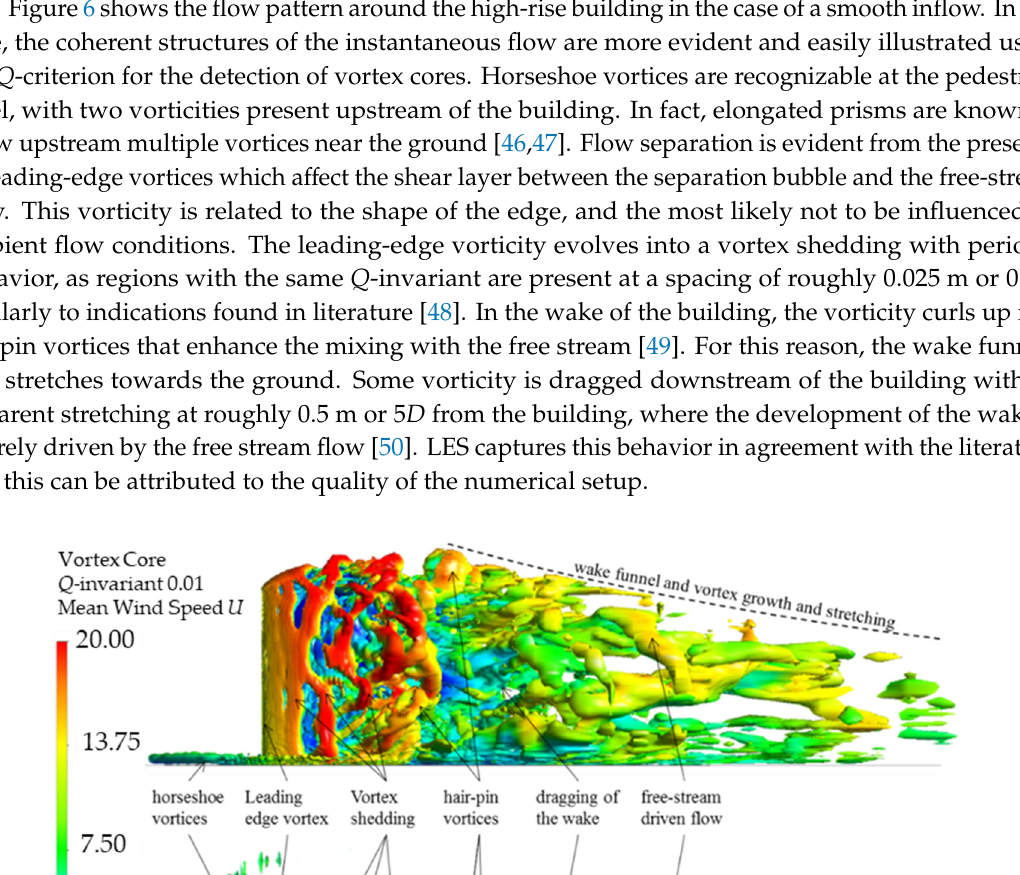
Figure 7. Flow pattern in terms of velocity-invariant Q = 0.1 around the high-rise buildingin case of ( a ) RANS smooth ; ( b ) RANS with fluctuating inlet, ( c ) LES smooth , and ( d ) LES with fluctuating inlet.